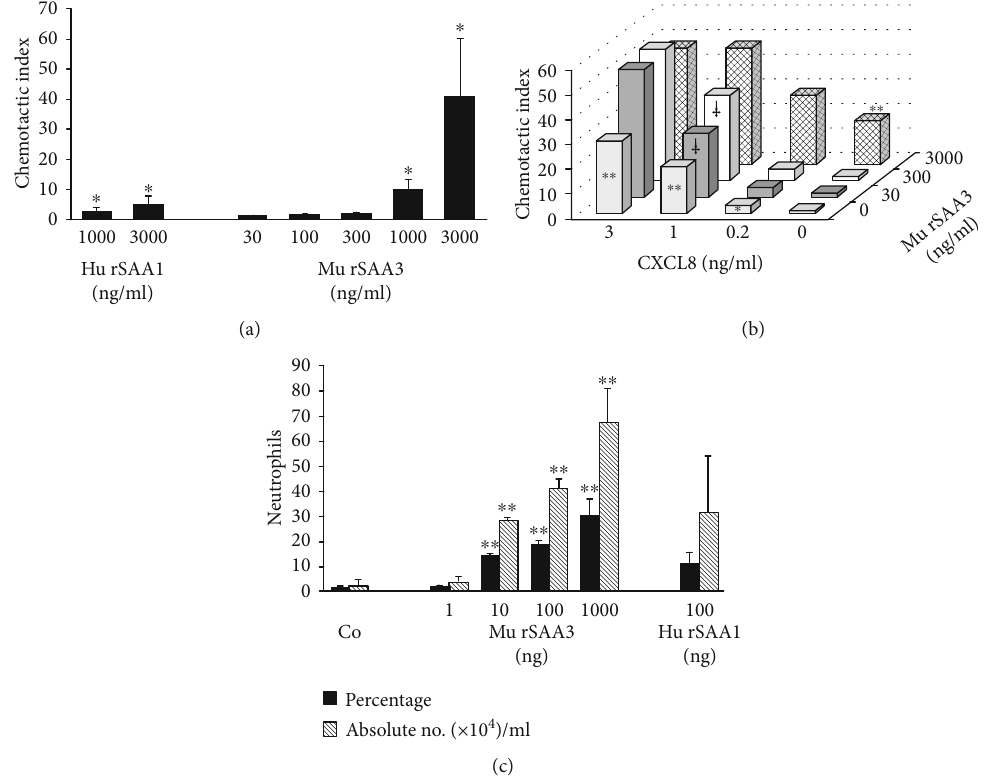
Figure 4: Impure mu rSAA3 is a potent neutrophil chemoattractant in vitro and in vivo and synergizes with CXCL8 in neutrophil migration. (a and b) The chemotactic activity of hu rSAA1 (1000 or 3000ng/ml) and mu rSAA3 (30-3000ng/ml) on human neutrophils was evaluated in the Boyden Microchamber Assay. The lower compartment of the microchamber was fi lled with chemoattractant alone (a) or with a combination of mu rSAA3 (30-3000ng/ml) and CXCL8 (0.2-3ng/ml) to assess synergy (b). The chemotactic potency is expressed as chemotactic index and is shown with (a) or without (b) SEM for 5-6 independent experiments. Statistically signi fi cant migration (compared to controls) and statistically signi fi cant synergy (compared to the sum of the values when both chemoattractants are tested separately), determined by the Mann-Whitney U test, are indicated by asterisks ( ∗ p < 0 : 05 ; ∗∗ p < 0 : 01 ) and daggers ( † p < 0 : 05 ), respectively. (c) Female NMRI mice were injected i.p. with 100 μ l of mu rSAA3 (1-1000ng), hu rSAA1 (100ng) or PBS (Co; 2-8 mice per group). After 2h, mice were sacri fi ced and peritoneal lavages were performed. Total cell counts in peritoneal lavages were determined and cytospins were prepared for di ff erential leukocyte counts by 2 individuals independently. Data represent the mean percentage (black bars) or absolute number × 10 4 /ml (hatched bars) of neutrophils ± SEM derived from 2 to 3 independent experiments. Statistically signi fi cant recruitment of neutrophils compared to PBS-injected mice, determined by the Mann-Whitney U test, is indicated by asterisks ( ∗∗ p < 0 : 01